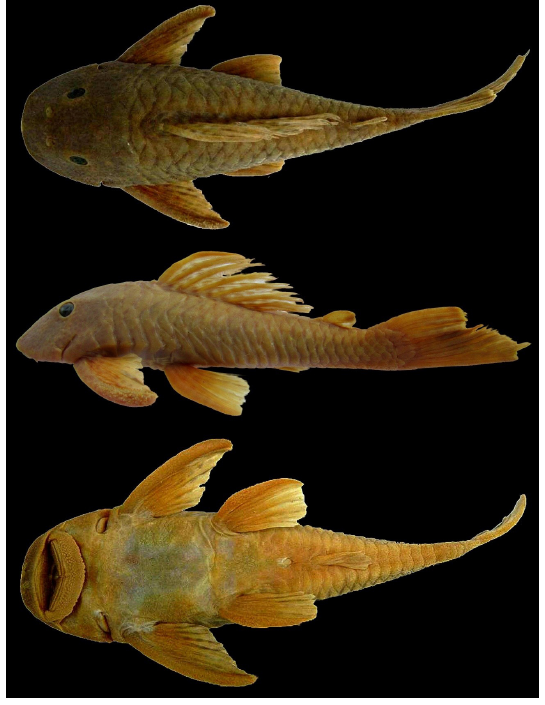
FIGURE 7 | Hypostomus vaillanti , UFRN 5648, 240.2 mm SL. Parnaíba River, Barão de Grajaú, Maranhão, Brazil.